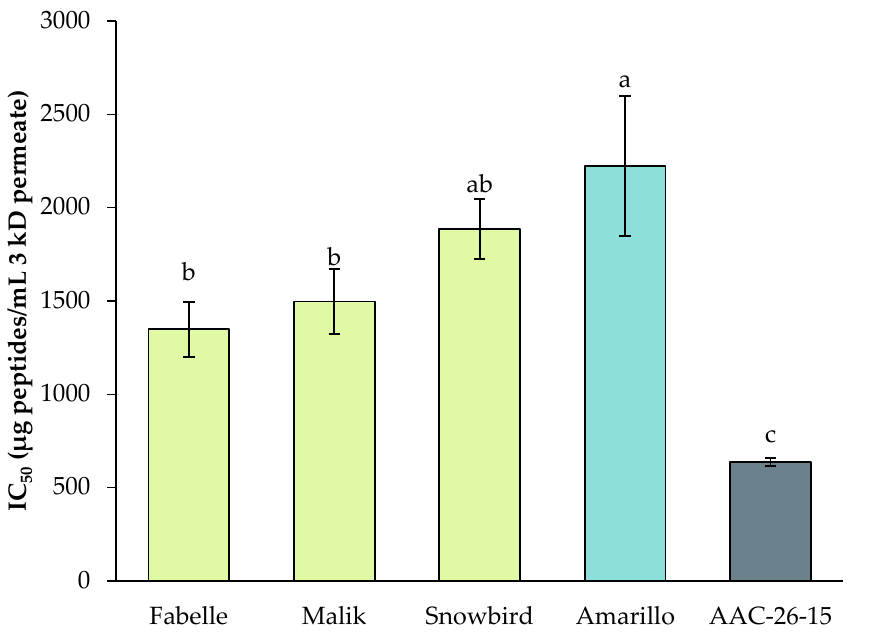
Figure 7. Antihypertensive activity (Angiotensin ‐ Converting Enzyme inhibition) of the 3 kDa permeate of legume digestates. Data are expressed as mean ± standard deviation and means without a common letter differ ( p < 0.05) as analyzed by one ‐ way ANOVA and the Tukey’s test.